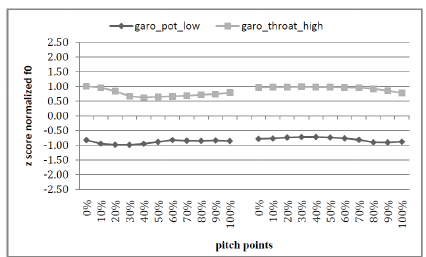
Figure 13: Normalized pitch contours for [garɔ], (n=20{5 speakers*4 iterations each})